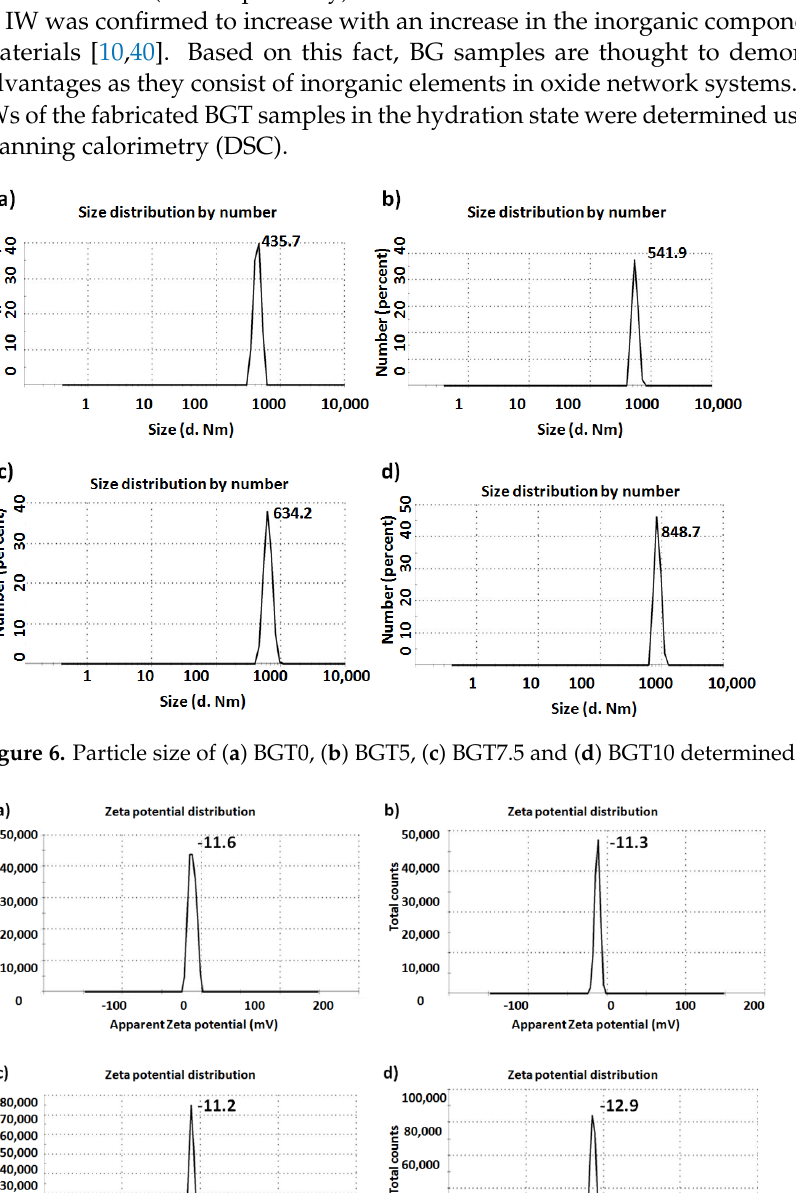
Figure 7. Particlesurface charges of ( a ) Base, ( b ) BGT5, ( c ) BGT7.5 and ( d ) BGT10 determined by Zetasizer.